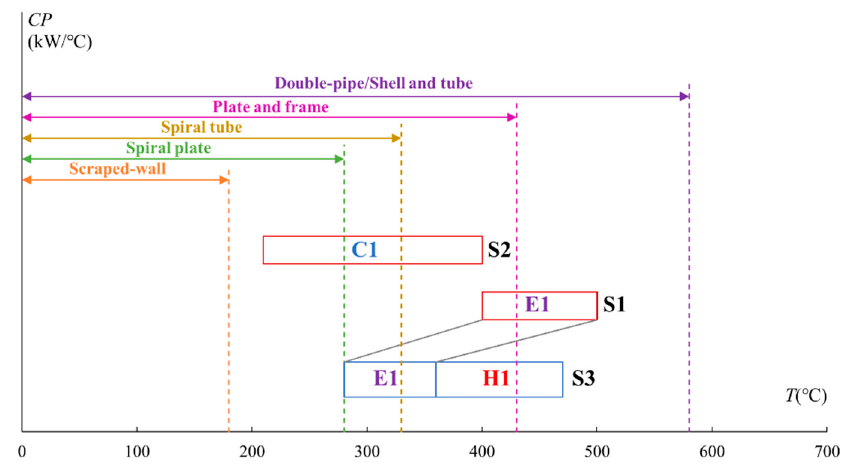
Figure 2. SRTGD-STR of the existing HEN for Example 1.